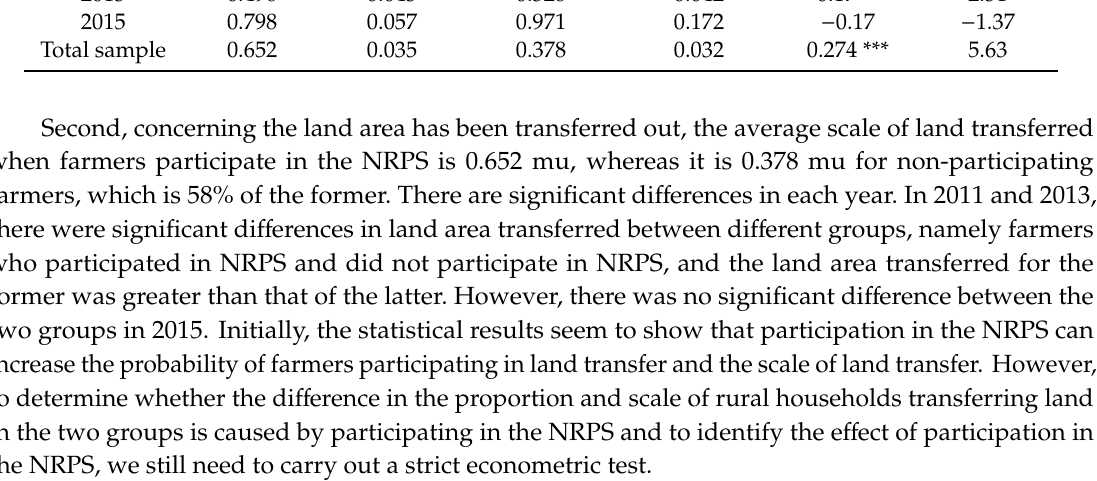
Table 2. Land area transferred out by farmers participating and not participating in the NRPS. Participating in NRPS Non-Participating in NRPS Year Mean